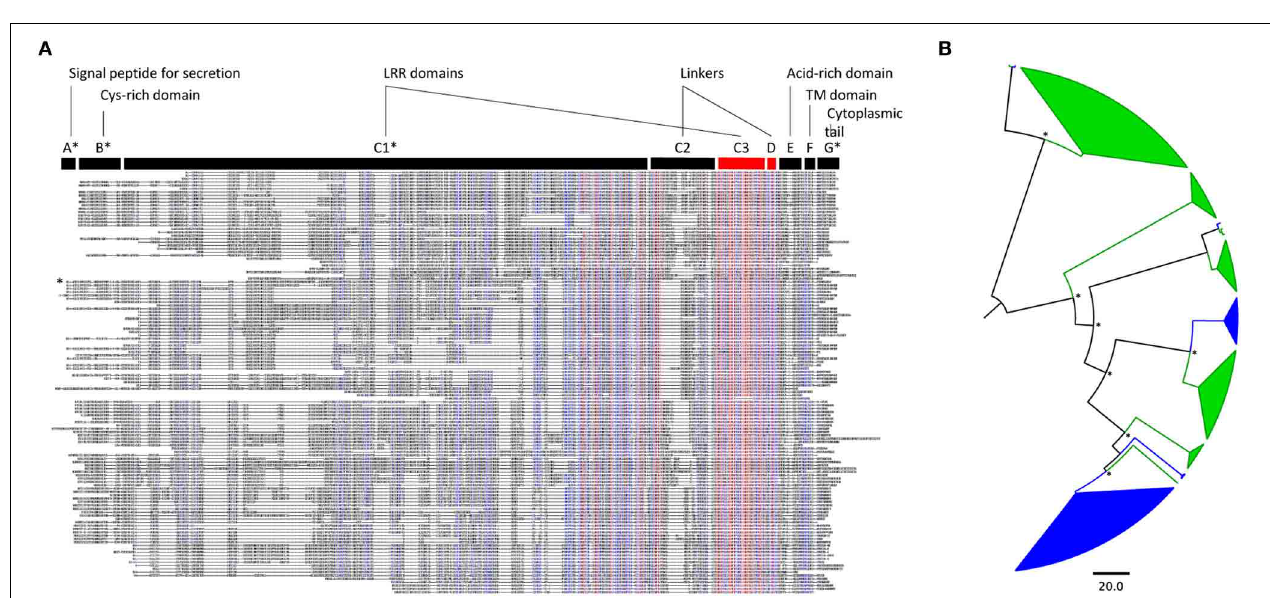
FIGURE 1 | Poplar and arabidopsis LRR-RLP families evolved independently. (A) Alignment of the protein sequences of the 82 and 45 LRR-RLP from poplar and A. thaliana , respectively. Blue and red colors indicate a minimum of 50 and 90% of amino acid identity per position, respectively. The canonical domains of tomato Cf-9-like LRR-RLPs described by Fritz-Laylin et al. (2005) are indicated above the alignment. The asterisks mark the domains that are variable in size and position within the alignment; they have been arbitrarily adjusted to correspond to the sequence of poplar